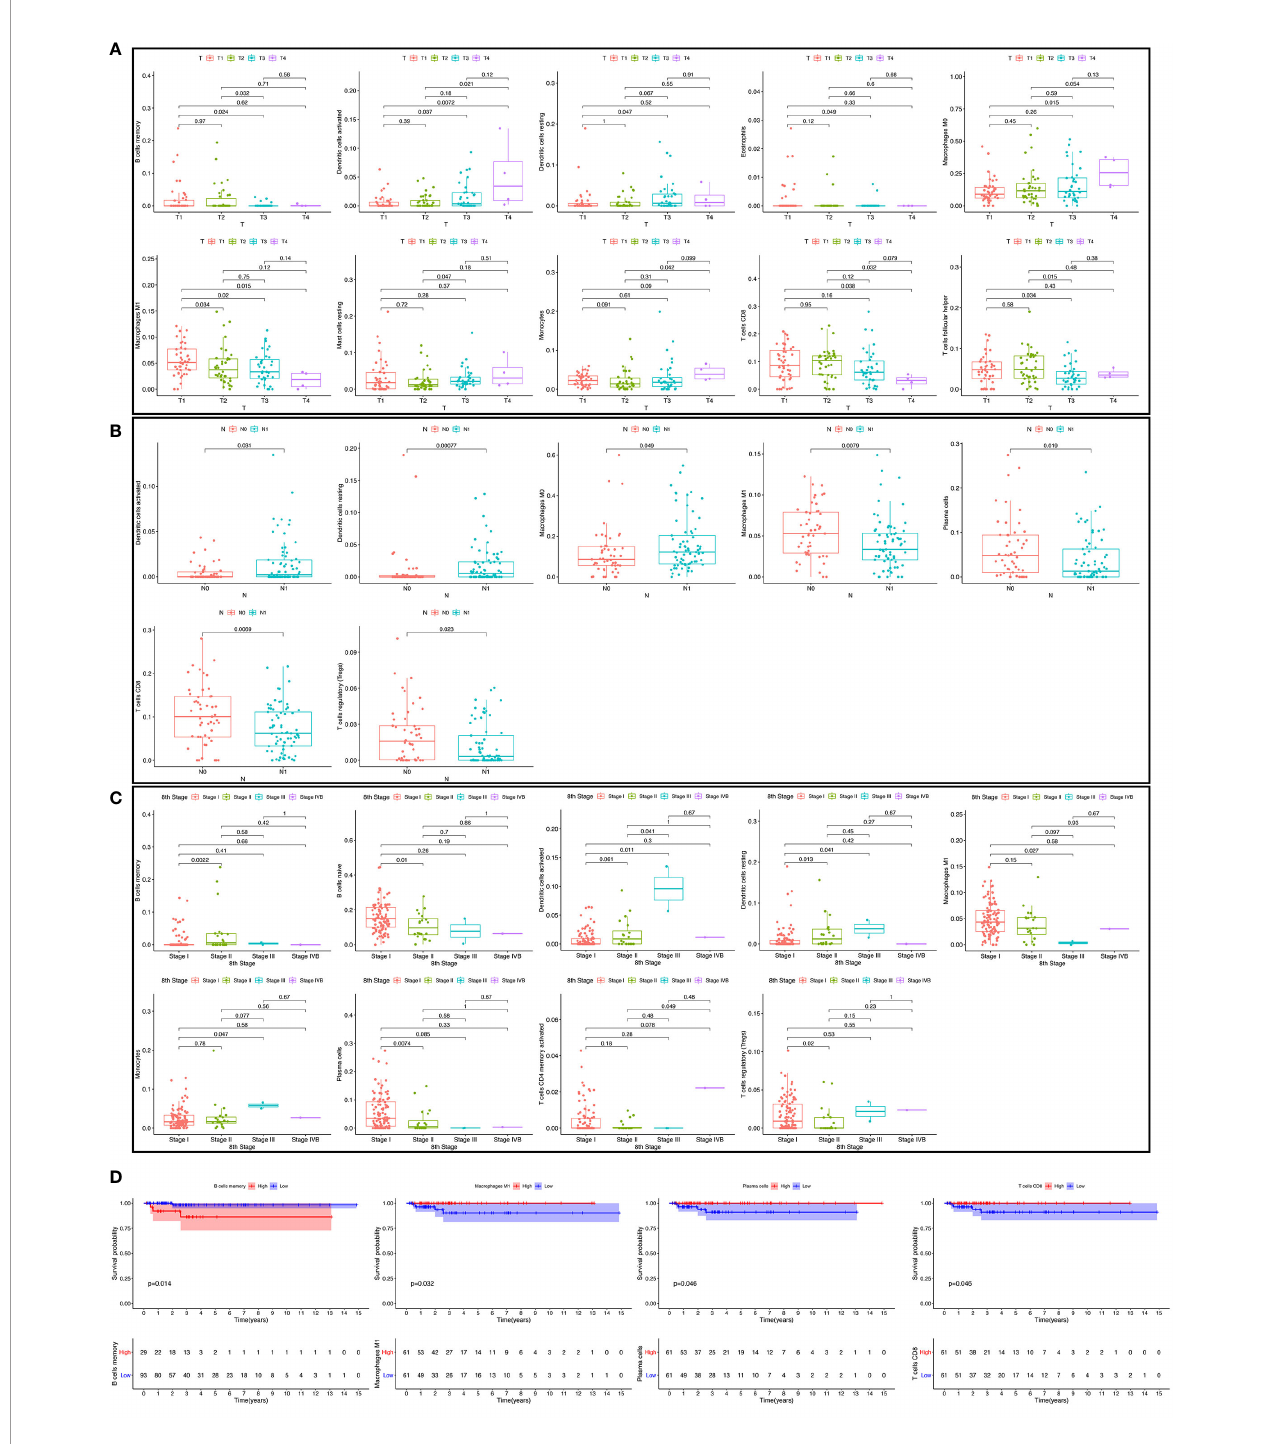
FIGURE 5 | The fraction of immune cells in the different T stages (A) . The fraction of immune cells in different lymph node metastasis situations (B) ; the fraction of immune cells in four tumor stages (C) ; the relationship between immune cell fraction and overall survival (OS) (D)